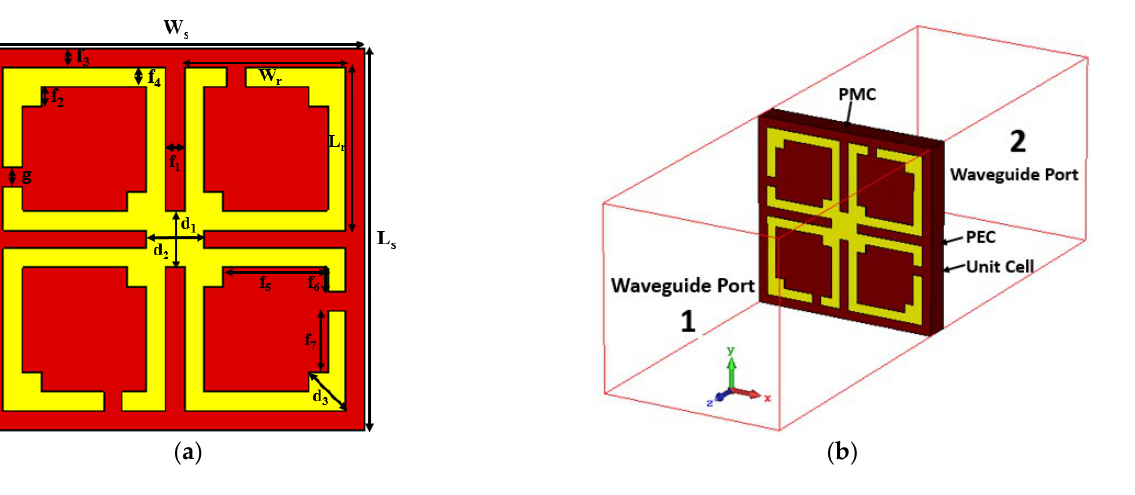
Figure 1. ( a ) Double negative (DNG) metamaterial with a symmetric structure and ( b ) unit cell sim- ulation with boundary setup. Table 1. Parameter values of the proposed DNG MM structure. Table 1. Parameter values of the proposed DNG MM